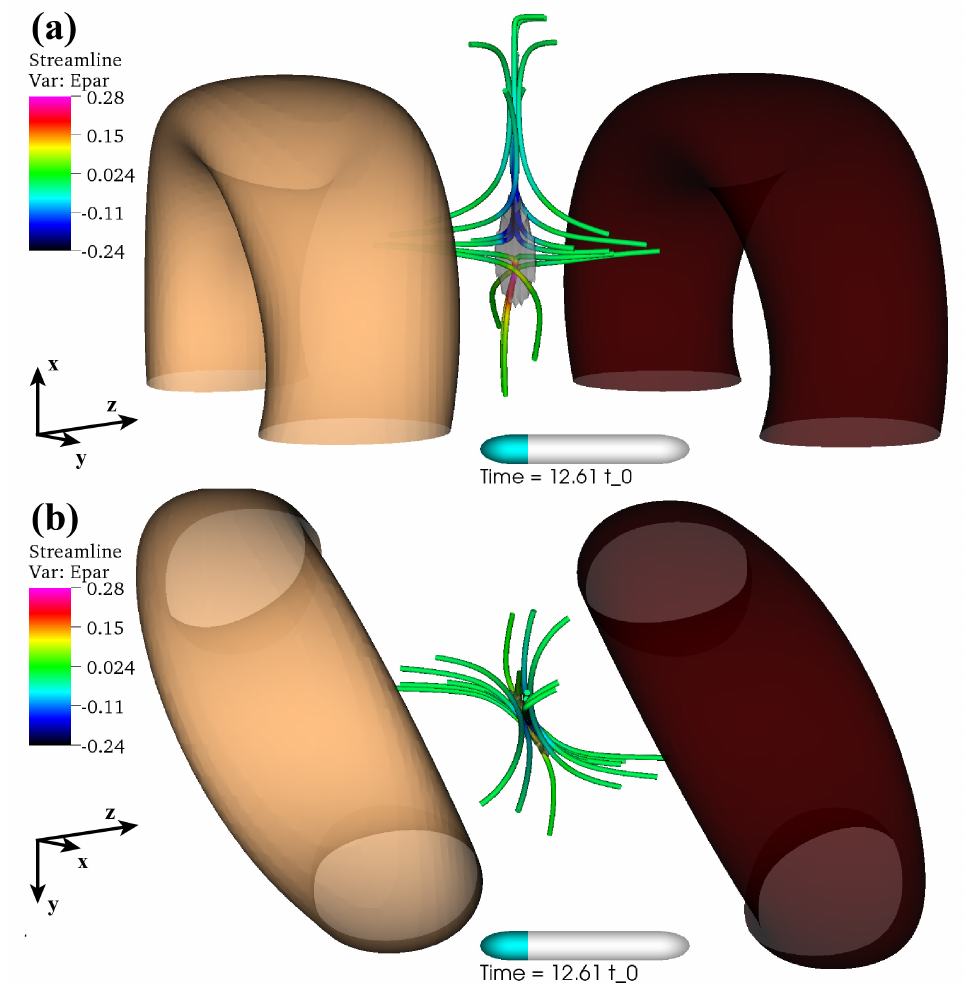
Fig. 7. Snapshots of the 3-D RR between the two flux bundles from a simulation with p | t = 0 = 0 . 25 p 0 , d i = 0, and ν = 5 × 10 − 6 at t = 12 . 61 t 0 . A view of the spine-fan magnetic null similar to that of Fig. 6 is shown in panel (a) and a view from the top is shown in panel (b) . Light and dark brown surfaces are those of constant r ˆ φ · A and approximate magnetic flux surfaces, the streamlines around the null are select magnetic field lines with the color showing parallel E -field ˜ E par = ˜ E · B / | B | at each location along the field lines, and a gray surface in the center of the null is that of enhanced current density |˜ J |= 30 . associated with ongoing magnetic